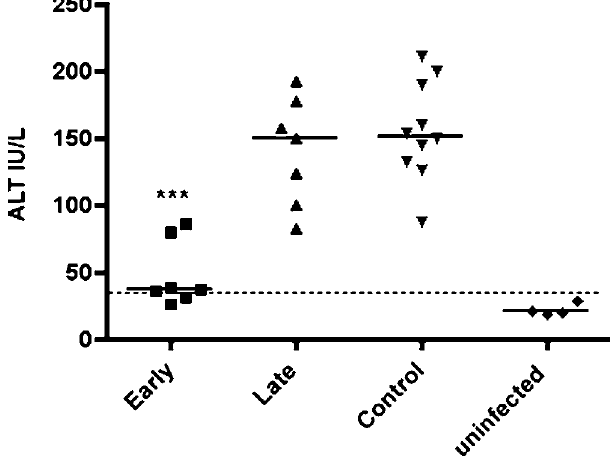
Figure 8. Early Treatment of S. mansoni –Infected Mice with K11777 Retards Hepatocellular Damage Arising from Parasite Eggs Plasma samples from mice in experiments outlined in Figure 1 were quantitatively assayed for the presence of ALT activity as a marker for hepatocellular damage. Points represent data from individual mice which were combined from either two early or late treatment experiments. The horizontal bars represent median values; *** p ¼ 0.002. For plasma from late-treatment mice, ALT activity was not significantly different ( p ¼ 0.9) from untreated controls, most likely due to the re-emergence of hepatocellular toxicity upon cessation of treatment at day 37 p.i.—i.e., 12 days prior to the end of the experiment and recovery of worms. The hatched line represents the baseline for age-matched uninfected mice.